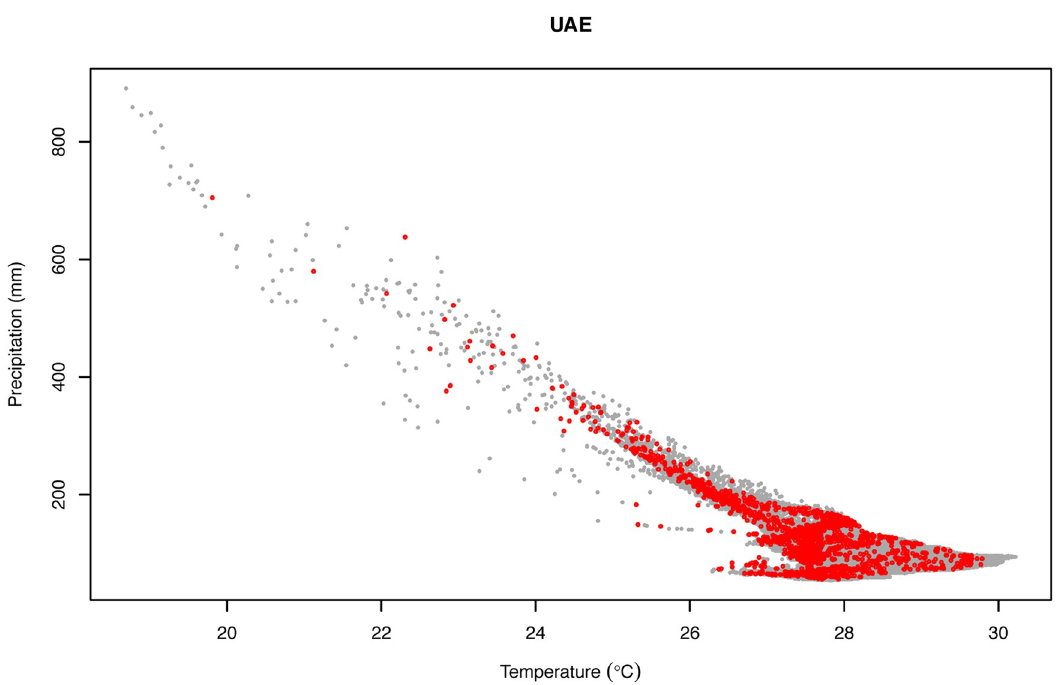
Fig 3. Two-dimensional climatic space of the UAE (grey dots) defined by the annual mean temperature (BIO1) and annual mean precipitation (BIO12). Red dots represent the distribution of the 5,535 occurrence records of all 60 species of terrestrial reptiles of the